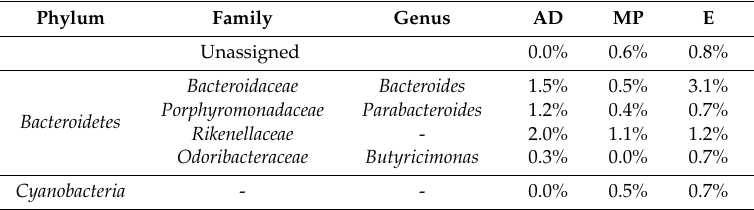
Table 5. Taxonomic profiles at genus level according to sampling moment in fast-growing management system.